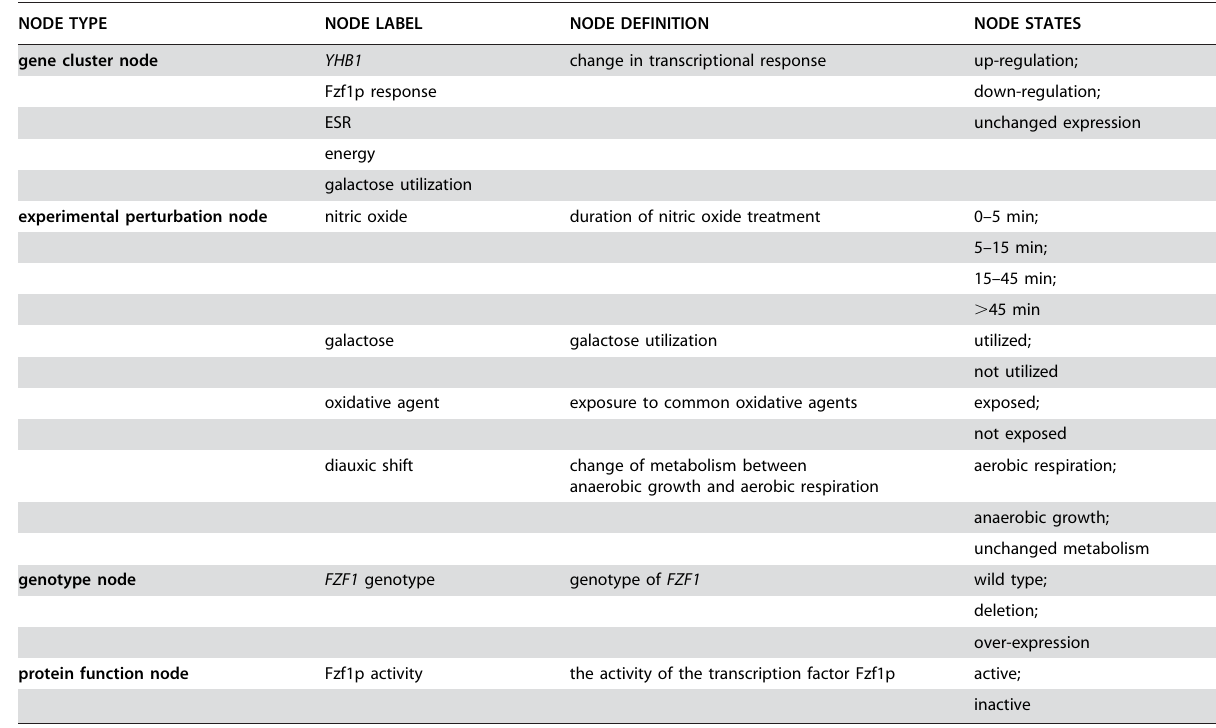
Node states for ‘‘galactose’’ were defined as ‘‘utilized’’ and ‘‘not utilized’’ depending on whether the substrate was introduced into the media. Similar states were defined for the node ‘‘oxidative agent’’. Table 2. Network nodes defined in the second nitric oxide response model. .. ... .... ... ... .... ... ... .... ... ... .... ... ... .... ... ... .... ... ... .... ... ... .... ... ... .... ... ... .... ... ... .... ... ... .... ... ... .... ... ... .... ... ...